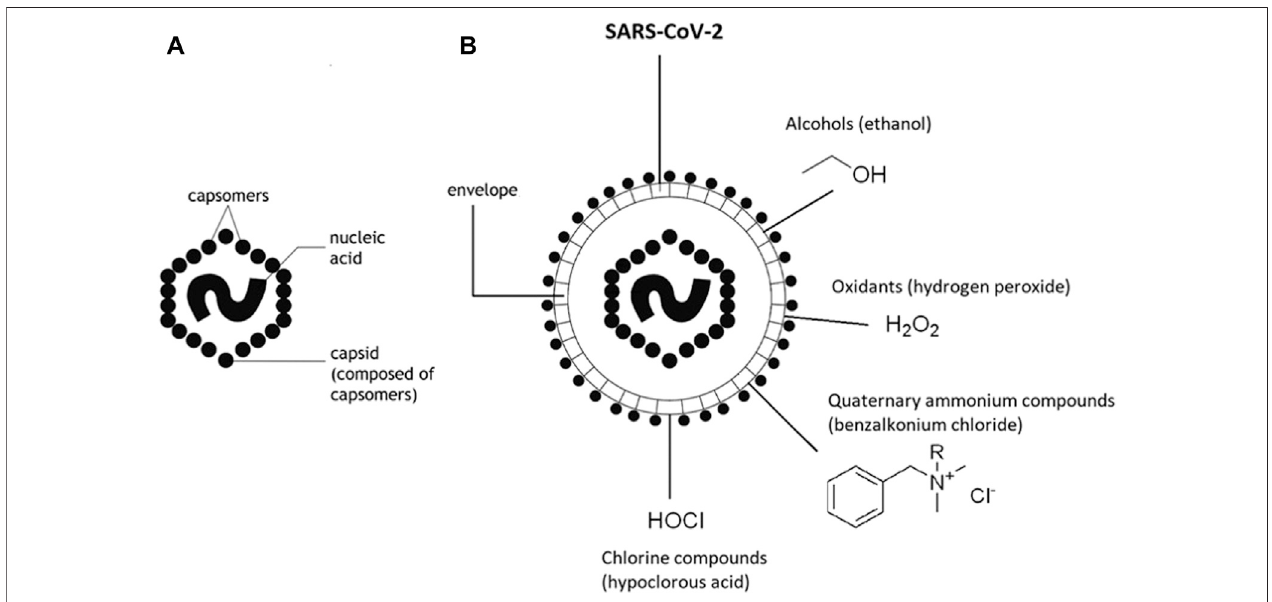
FIGURE 1 | Factors in fl uencing biocidal